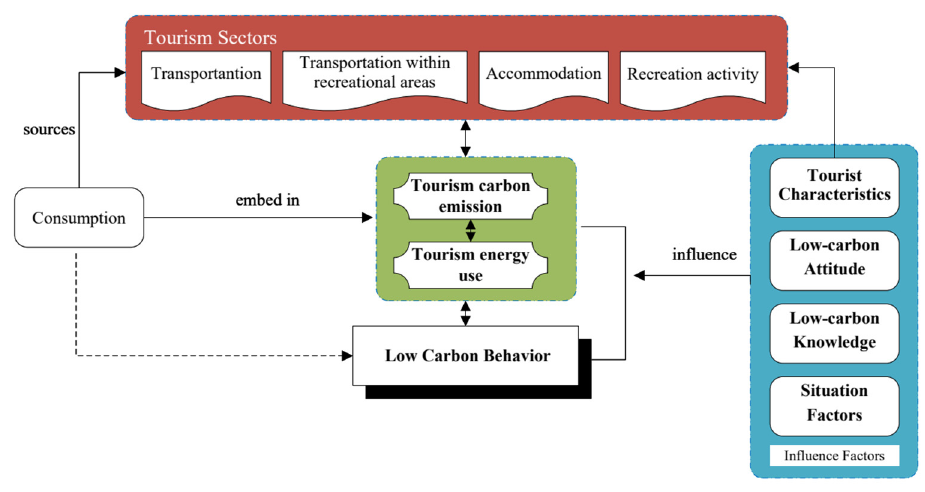
Figure 1. Theoretic analysis framework.